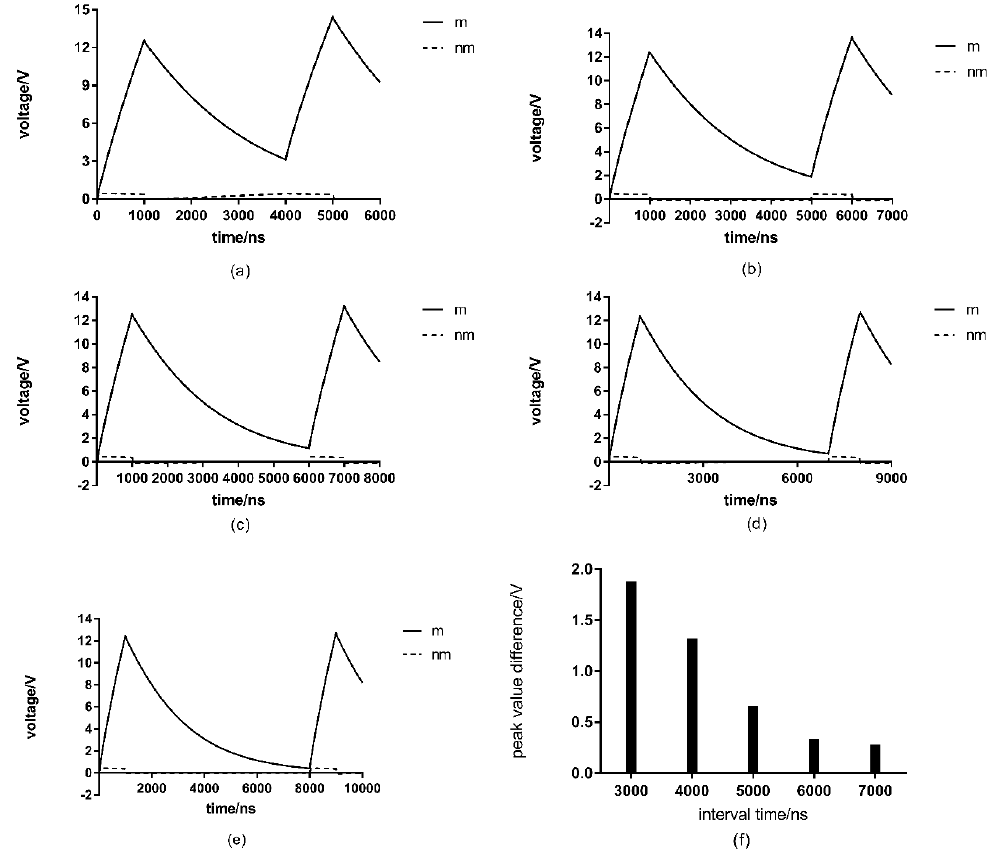
Figure 3. Results of double-pulses at di ff erent intervals: ( a ) 3000 ns; ( b ) 4000 ns; ( c ) 5000 ns; ( d ) 6000 ns; ( e ) 7000 ns; ( f ) the di ff erence between the peak cell membrane transmembrane voltage of the first pulse and the peak cell membrane transmembrane voltage of the second pulseat di ff erent intervals; m stands for the cell membrane transmembrane voltage and nm stands for nuclear membrane transmembrane voltage.